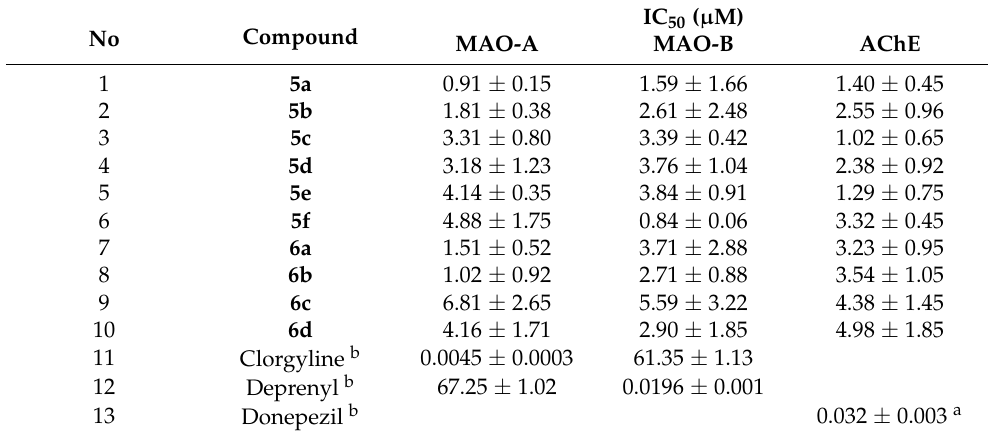
Table 1. IC 50 values of synthesized compounds towards MAO-A, MAO-B, and AChE enzymes.